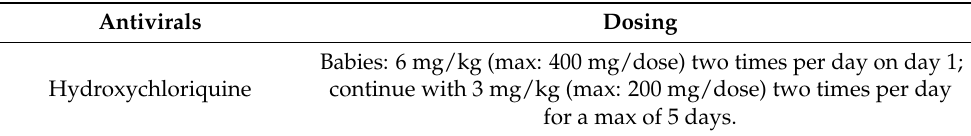
Table 6. Summary of COVID-19 Hydroxychloriquine dosing.